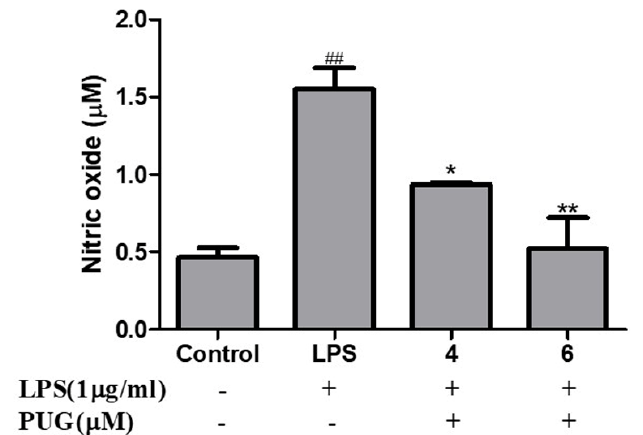
Figure 3. Effect of PUG on nitric oxide (NO) release on RAW264.7 macrophage cells. RAW264.7 cells were pretreated without and with LPS (1 µ g/mL) for 1 h at 37 ◦ C. Then the cells were treated with PUG (4, and 6 µ M) for 24 h at 37 ◦ C. After treatment, the medium was collected and used for the assay. A NO detection kit was used to determine the NO concentration in the samples. The samples were measured at 520 nm. The absorbance values of the standards and samples were used to plot the graph. The statistical significance was ## p < 0.01 vs. untreated group; and * p < 0.05, ** p < 0.01 vs. LPS-alone treated group.